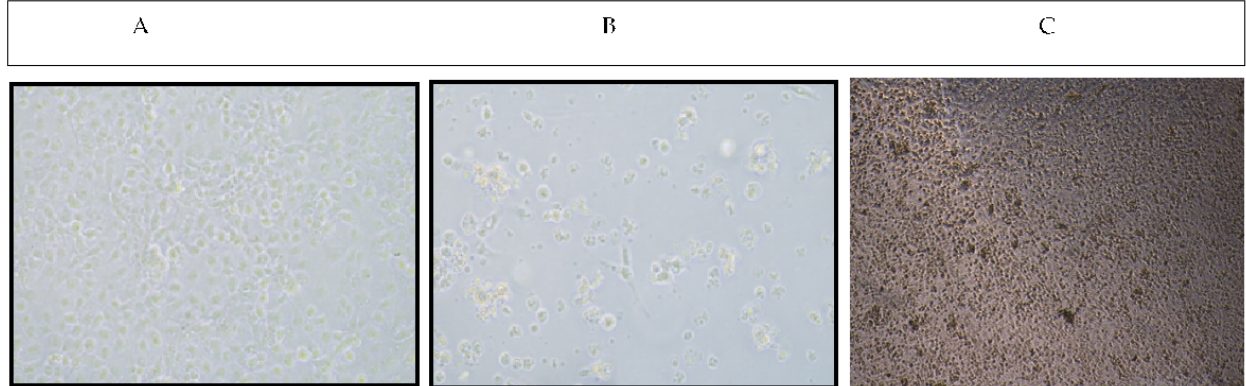
Figure 2. Susceptibility of E-11 cells to nodavirus and chitosan treatment ( A ) Confluent uninfected E-11 cells at day 4 post-seeding. ( B ) Extensive CPE with multiple vacuolation in E-11 cells infected with nodavirus at day 4 post inoculation. ( C ) Nodavirus infected E-11 cells treated with 0.3% Chitosan at day 4 post inoculation.